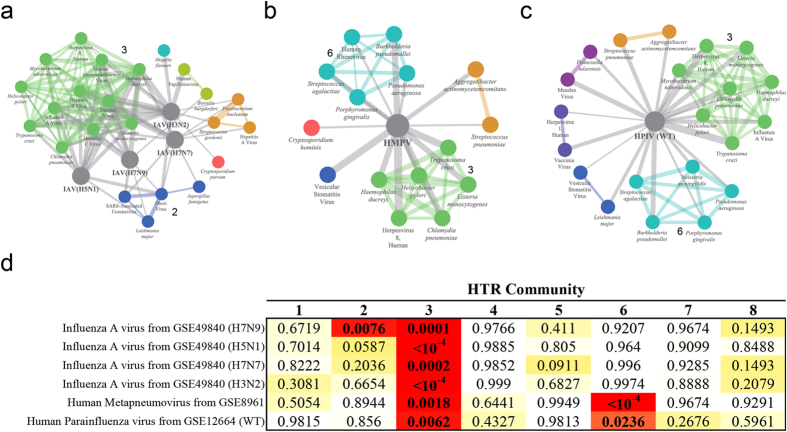
Respiratory virus HTR associations.Subcommunities connected to external respiratory viruses, including (a) IAV, (b) hMPV, and (c) hPIV (wild-type), when each was integrated into the HTR community. (d) Permutation P values for associations between external pathogen signatures and each HTR community. Grey magnified nodes represent query signatures generated from host transcriptional expression profiles (detailed information is provided in Supplementary Table S6). For clarity, we included only pathogen pairs with association scores > 0.5, and HTR communities with a permutation P value < 0.05 are shown in bold. Edge thicknesses are proportional to association scores; edge and node colors are consistent with Figs 3 and 5, 6, 7. Association scores between external query signatures and mPRLs are reported in Supplementary Data S8.